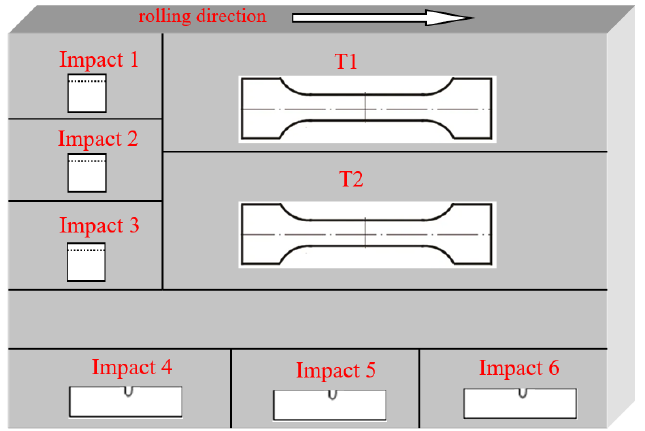
Figure 3. Normalizing cooling process curve. Figure 4. Diagram of steel plate performance inspection. Figure 4. Diagram of steel plate performance